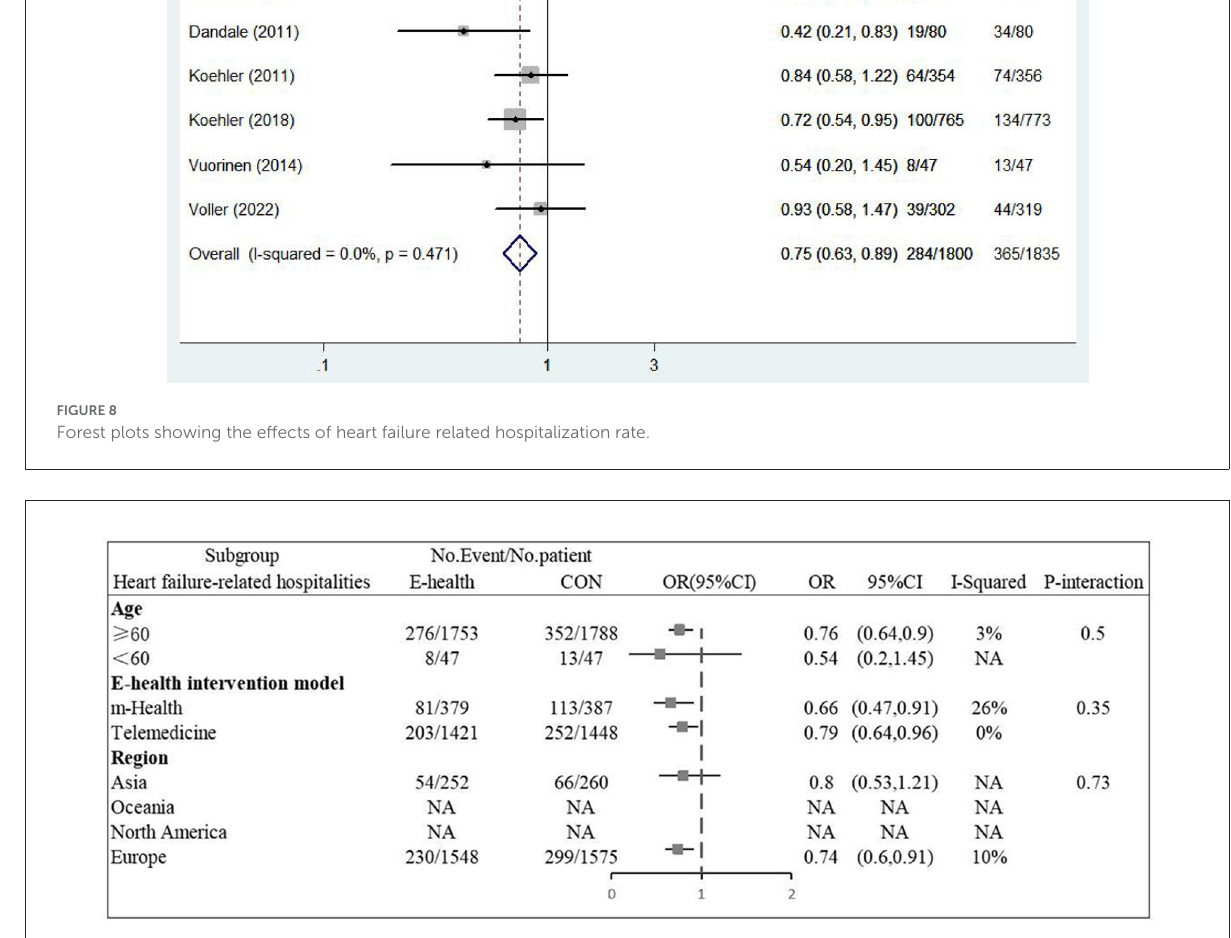
FIGURE9 Subgroup analysis for outcome of heart failure related hospitalization